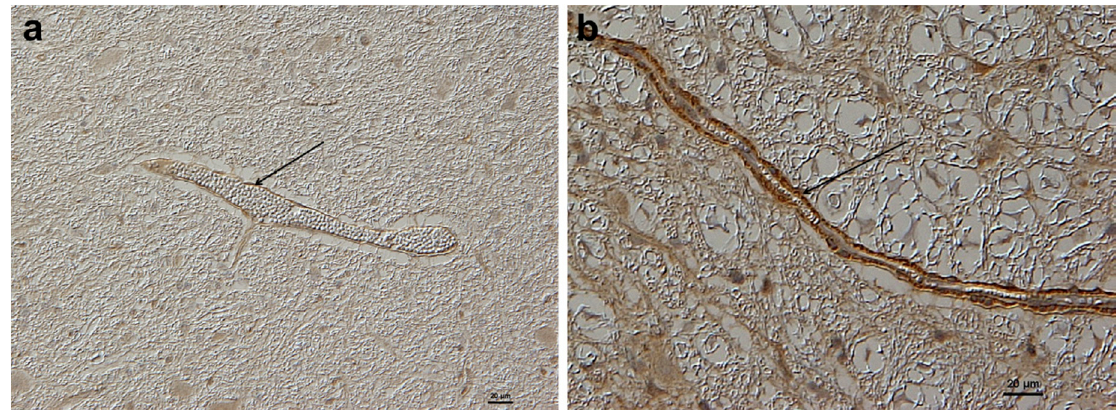
Figure 3. Comparison of CTR1 expression in BBB of adult sheep cerebellum of both domesticated and feral North Ronaldsay sheep. ( a ) Domesticated sheep (control) cerebellum (Cu 15.4 (µg/g) showing weak CTR1 expression in brain capillary of the BBB (arrow). ( b ) North Ronaldsay sheep cerebellum (Cu 35.0 (µg/g) showing strong CTR1 expression in capillary endothelium of BBB (arrow). Immunostain for CTR1 [26,27]. (Reproduced with permission from Haywood, J. Comp. Path.; published by Elsevier Ltd, 2013).